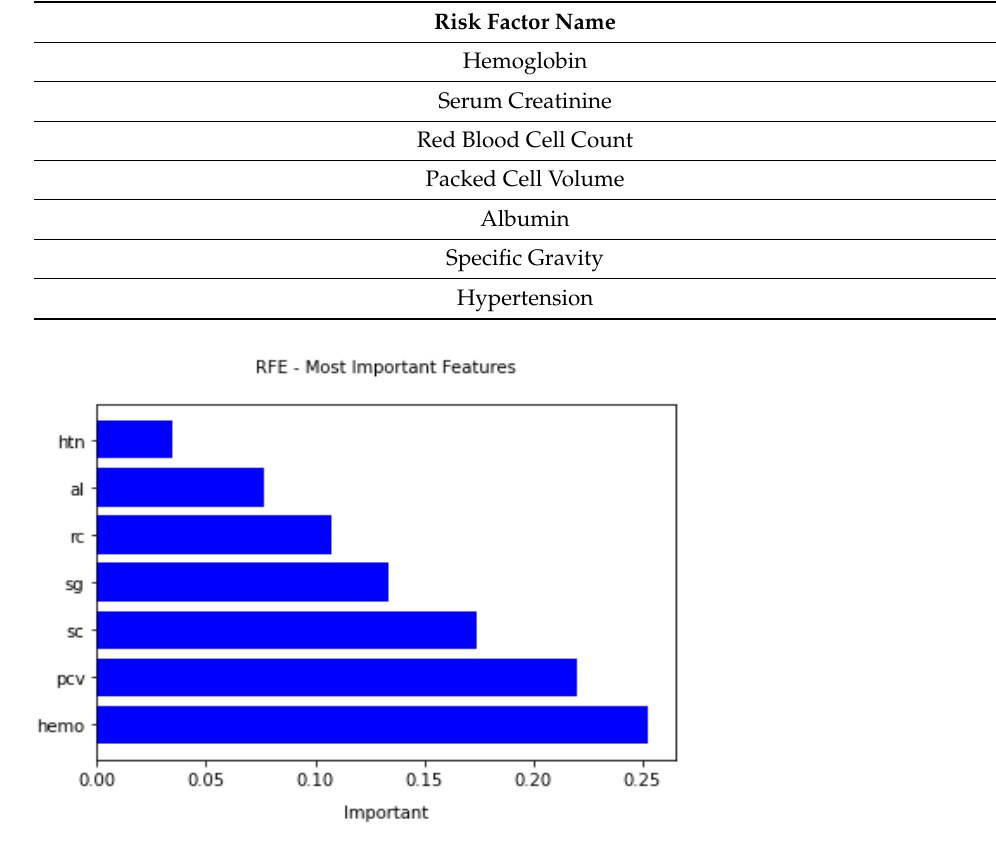
Figure 11. Important features selected by RFE. Table 7. The most critical risk factors from CKD data.